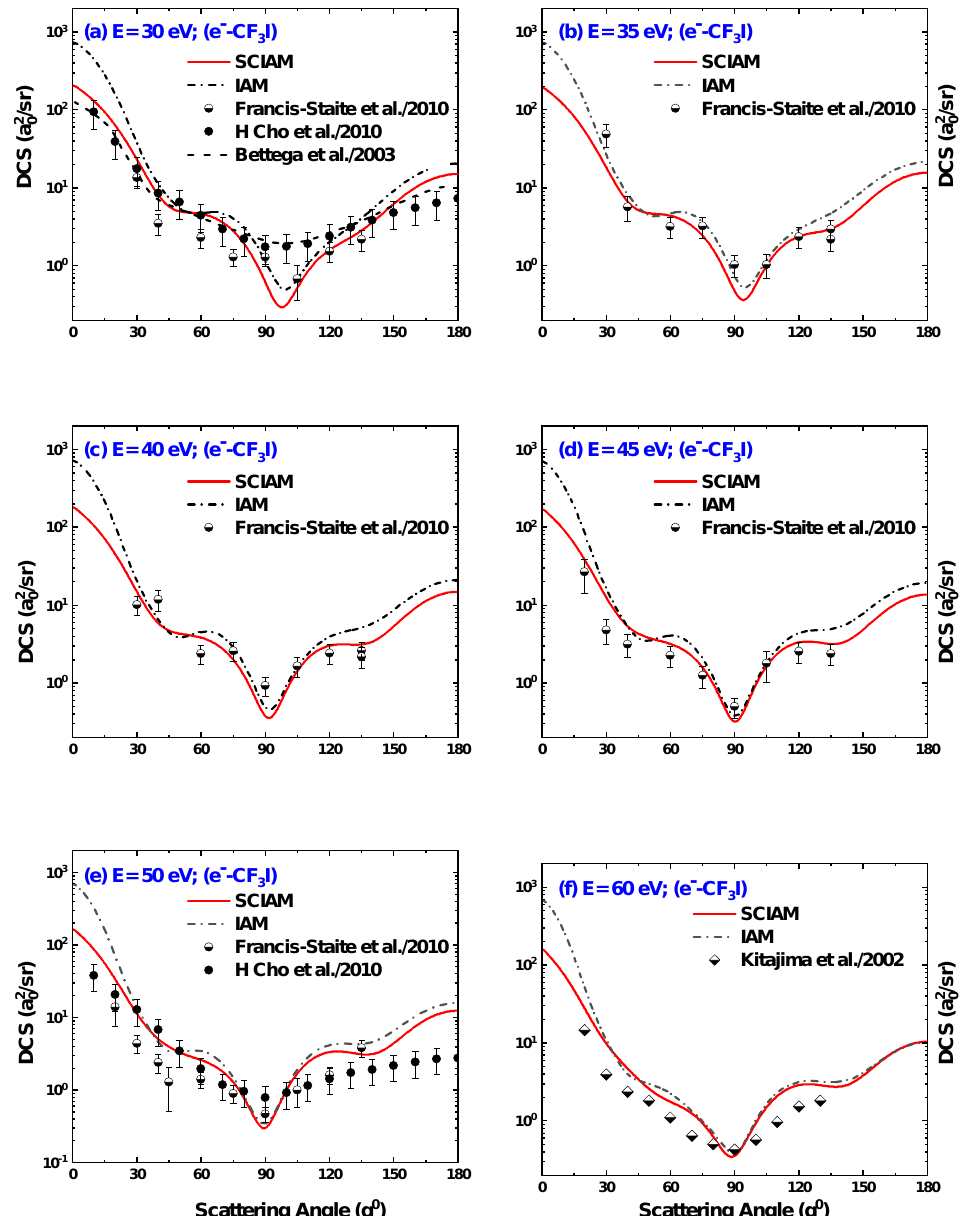
Figure 2. DCS ( a 2 / sr ) for the elastic scattering of electrons from CF 3 I at incident energies 30, 35, 0 40, 45, 50, and 60 eV. Theoretical works: SCIAM, IAM, and Bettega et al. [30]. Experimental works: Francis-Staite et al. [25], H Cho et al. [26], and Kitajima et al.